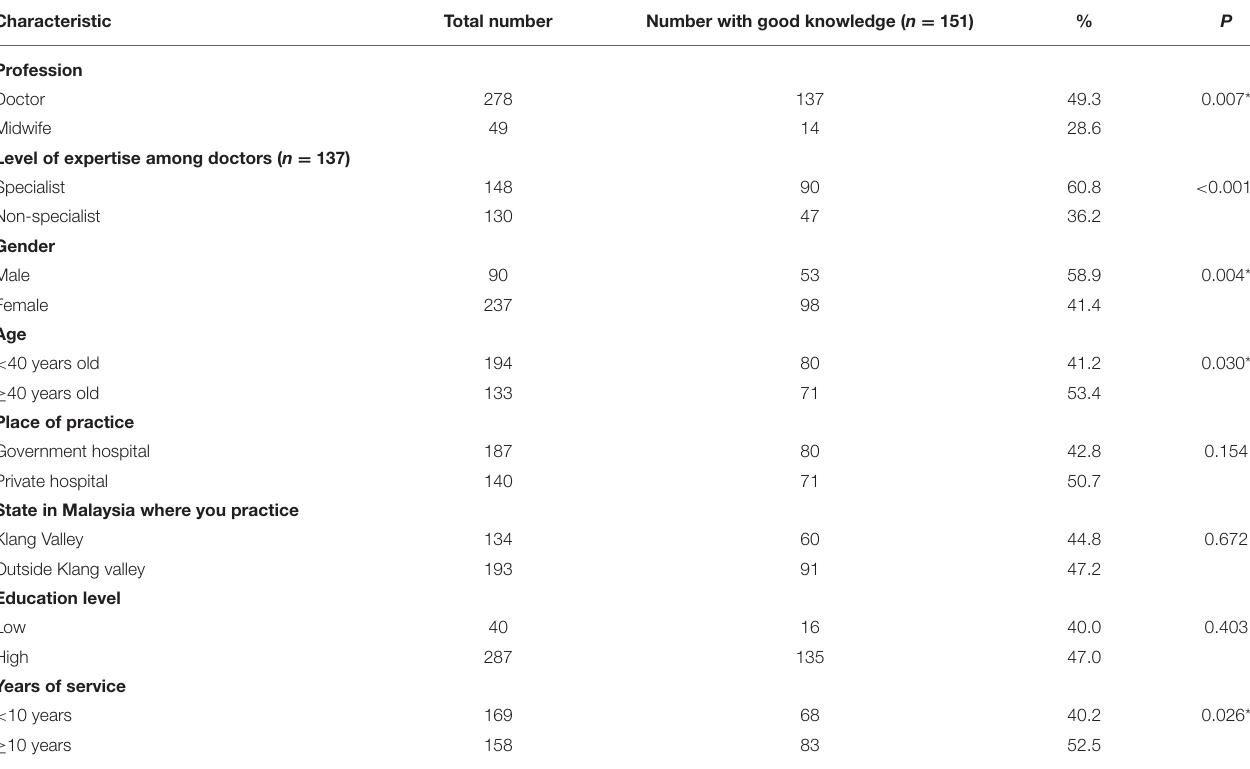
TABLE 5 | Number and percentage of respondents with positive attitude and good knowledge toward DCC by demographic characteristics.